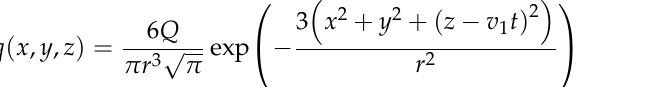
Figure 6. Schematic diagram of heat source path. ( a ) linear heat source path, ( b ) sinusoidal path heat source, ( c ) oscillate-stop heat source path.